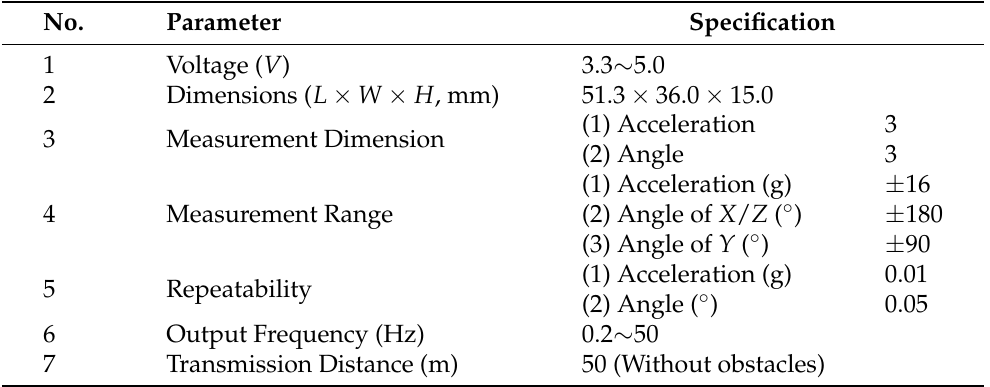
Table 2. Main parameters of the